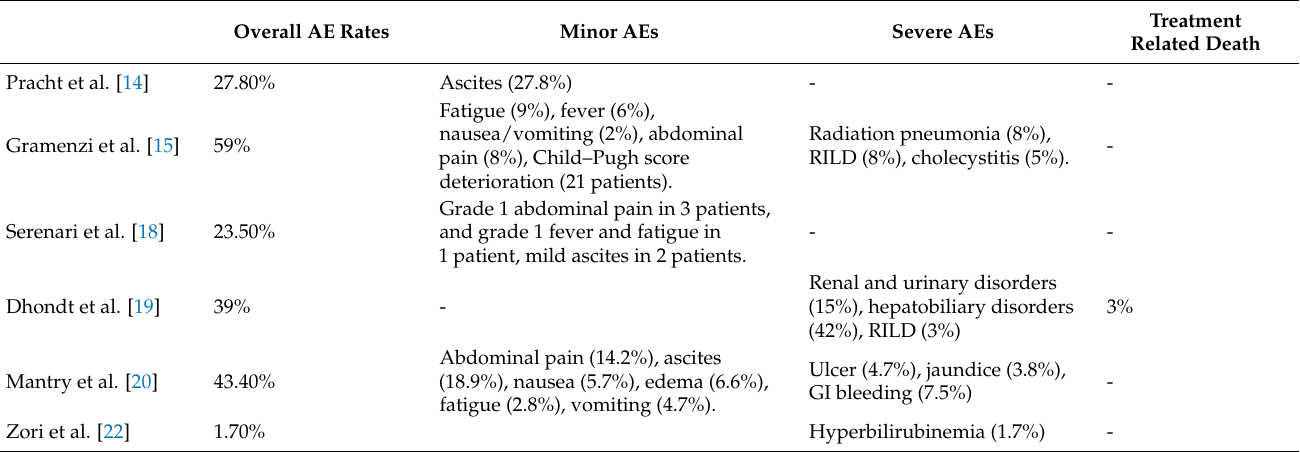
Table 3. Adverse events after